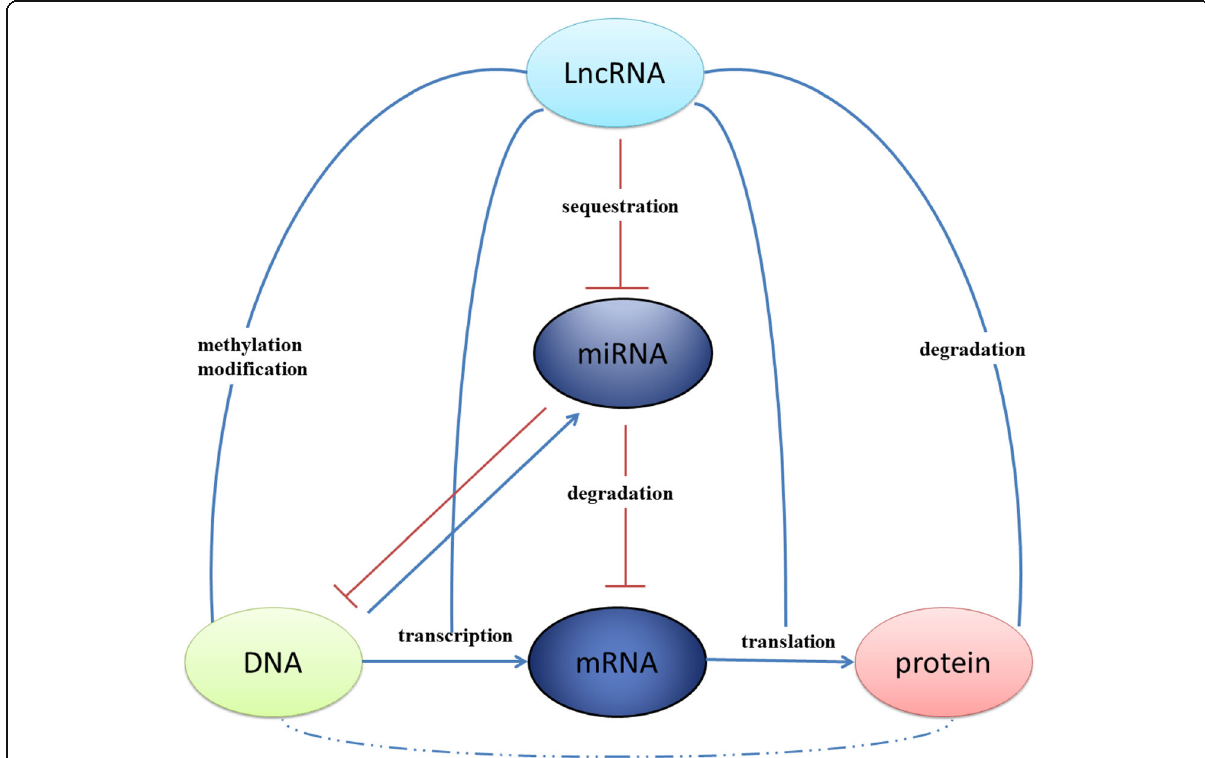
Fig. 1 The lncRNA-miRNA-mRNA regulation